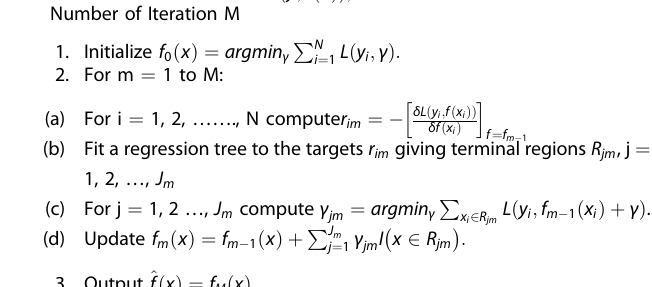
GBR is given below.